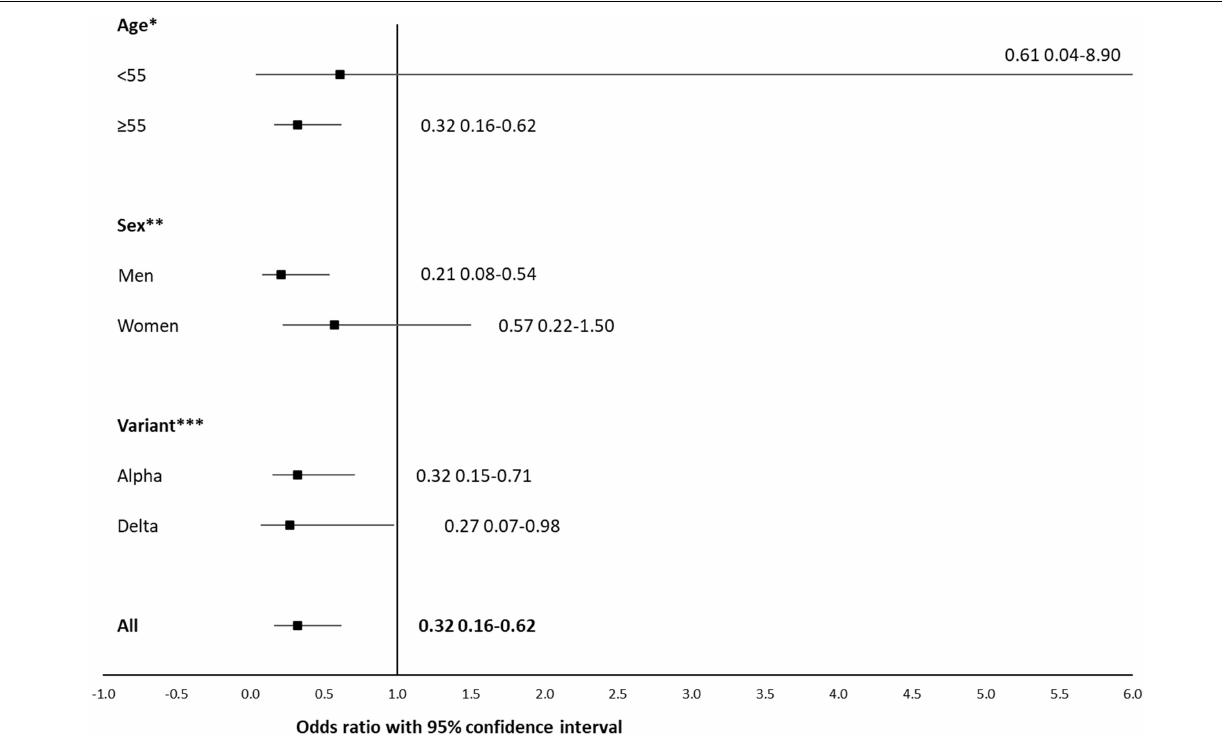
Frontiers in Microbiology |